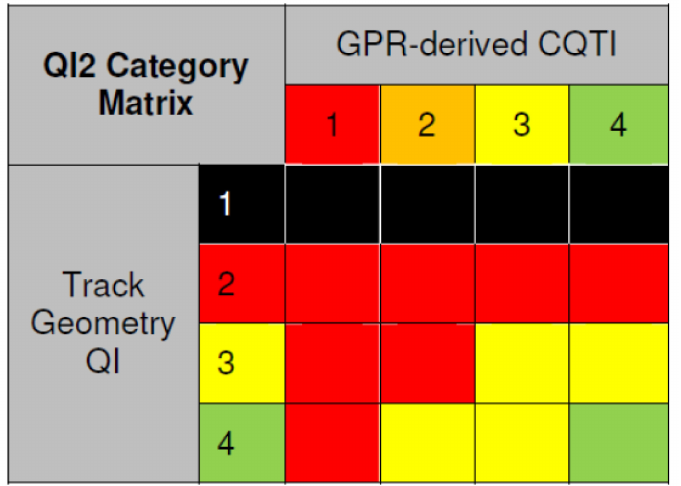
Figure 18. QI2 rules matrix between CQTI and track geometry QI (figure reproduced from